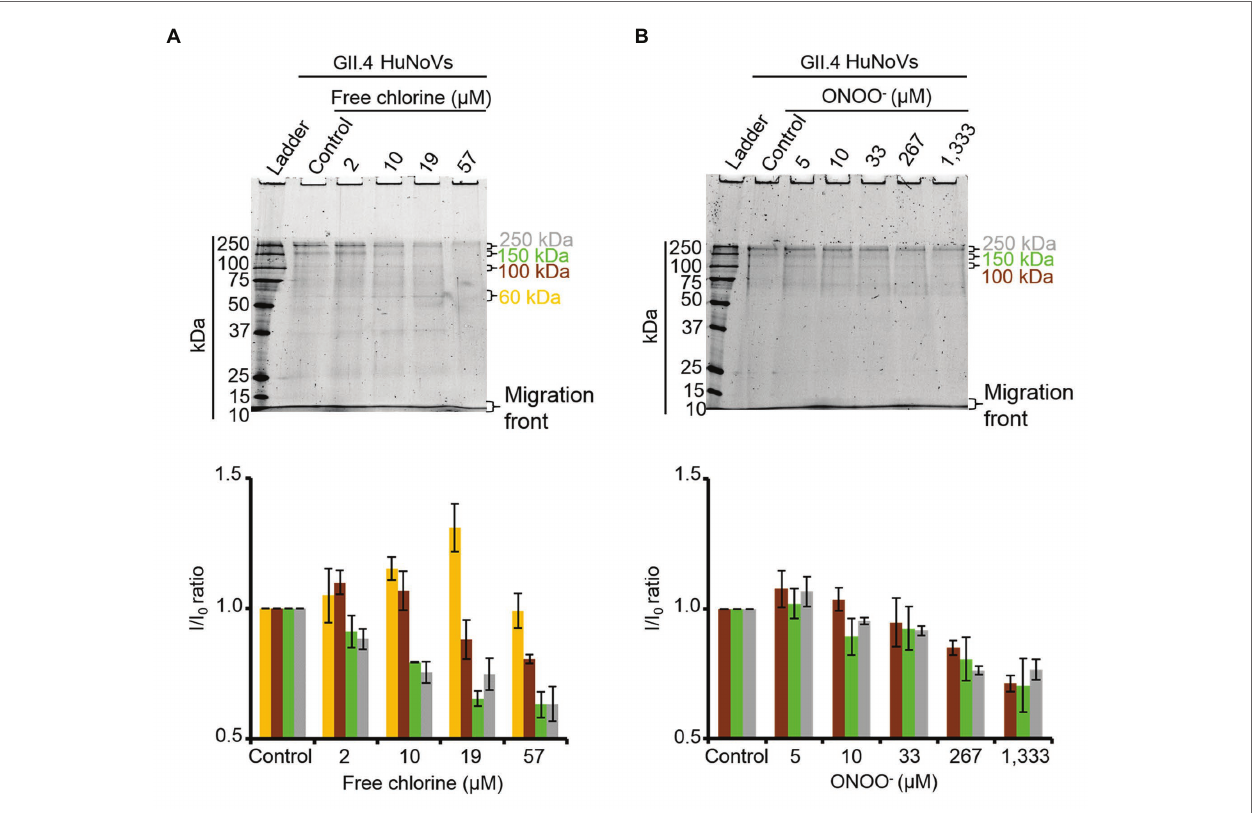
FIGURE 4 | Free chlorine and ONOO − modify the capsid proteins of GII.4 HuNoVs. GII.4 HuNoVs were analyzed using SDS-PAGE following free chlorine (A) or ONOO − (B) treatments without heat treatment. The variations in intensity of protein bands obtained using SDS-PAGE gel were measured for both oxidative treatments (see histograms below the gels of the respective conditions). The intensity of protein bands (I/I 0 ratio) was determined by dividing the mean intensity value of each band obtained at a specific molecular weight after oxidative treatment (I) by the mean intensity value of the same bands obtained in the control without oxidant (I 0 ). Each data point is an average of three independent experiments conducted on different days. The intensity of the protein bands was separated into groups, as indicated by the color code on the right-hand side of the gels (60 kDa, 100 kDa, 150 kDa, and 250 kDa are shown in yellow, brown, green, and gray colors, respectively). Error bars indicate standard